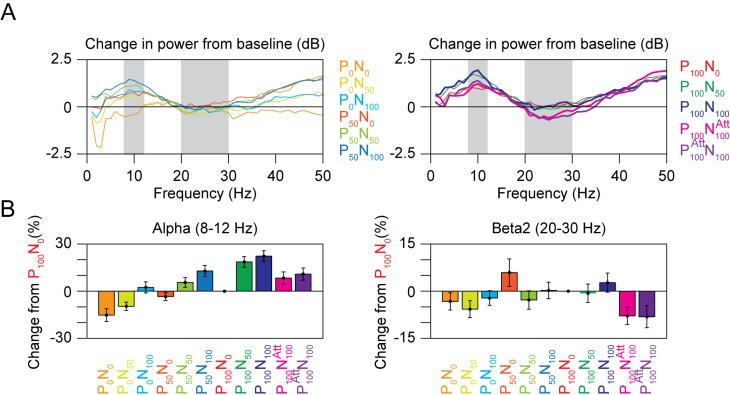
Effect of normalization and attention at low frequencies.(A) Change in power from baseline, for nine normalization and two attention conditions. The data are shown in two plots for clarity. Alpha and beta2 bands are shaded in gray. (B) Change in power from the P100N0 condition in the alpha (left) and beta2 (right) band.